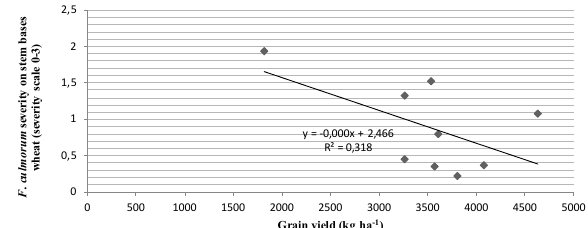
Figure 11. Correlation between disease severity index (scale 0-3) and grain yield (kg ha -1 ) of durum wheat harvested from three demonstration trials at Fernana,